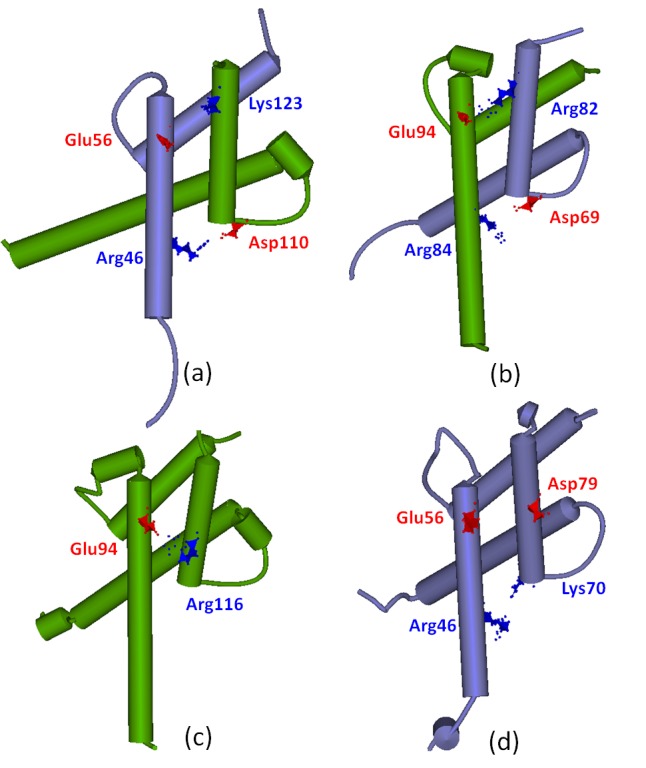
Charged residues in the binary models.Some positive-charged residues (blue polyhedron) and the negative-charged residues (red polyhedron) at the H1-H2 interfaces in the CbHLH+BbHLH model ((a) and (b)), the BbHLH+BbHLH model (c), and the CbHLH+CbHLH model (d)